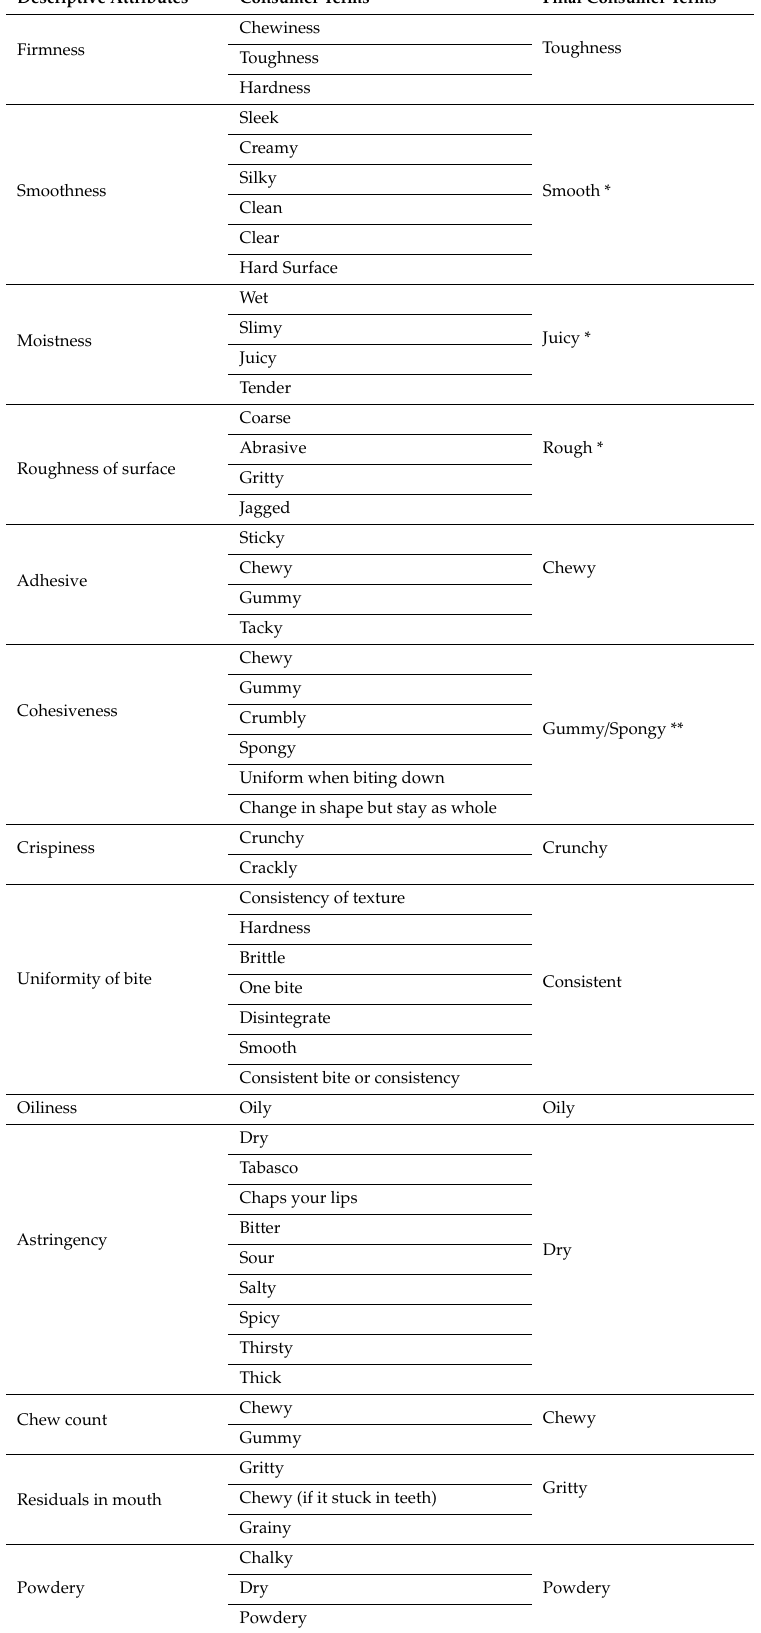
Table 4. Consumer texture terms provided by the English-speaking group